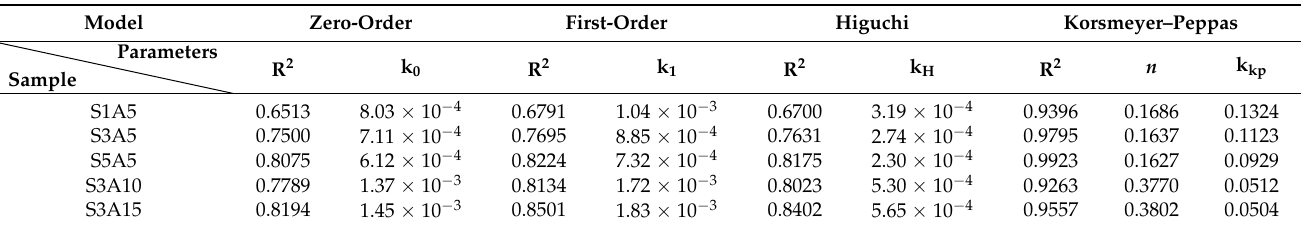
Table 2. Fitting parameters of drug release kinetics of Sal-B from the dual drug-loaded biomimetic composite scaffolds.